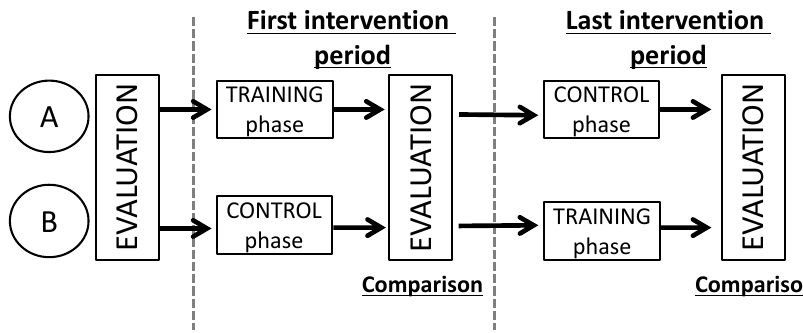
Figure 7. Evaluation and training period.